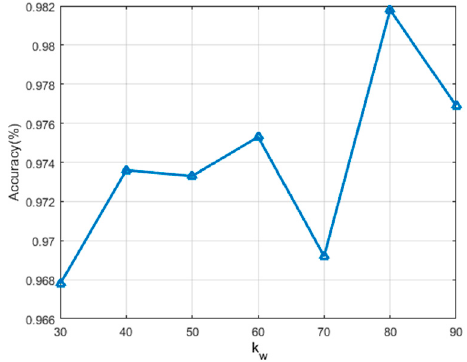
ff ect of k k w on the classification on the classification accuracy. Figure 6. E